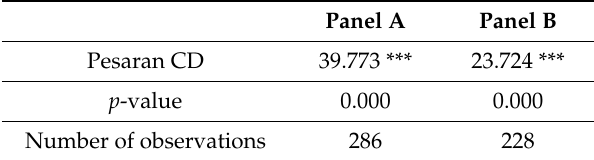
Table A1. Results of Cross-sectional Dependence Test.